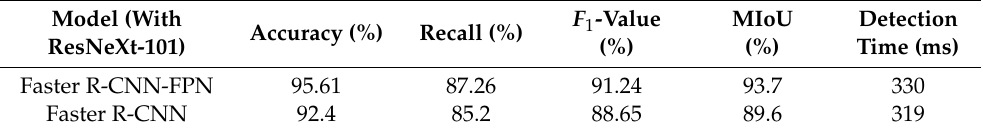
Table 1. Performance comparison of the faster R-CNN-FPN network and ordinary Faster R-CNN. Model (With